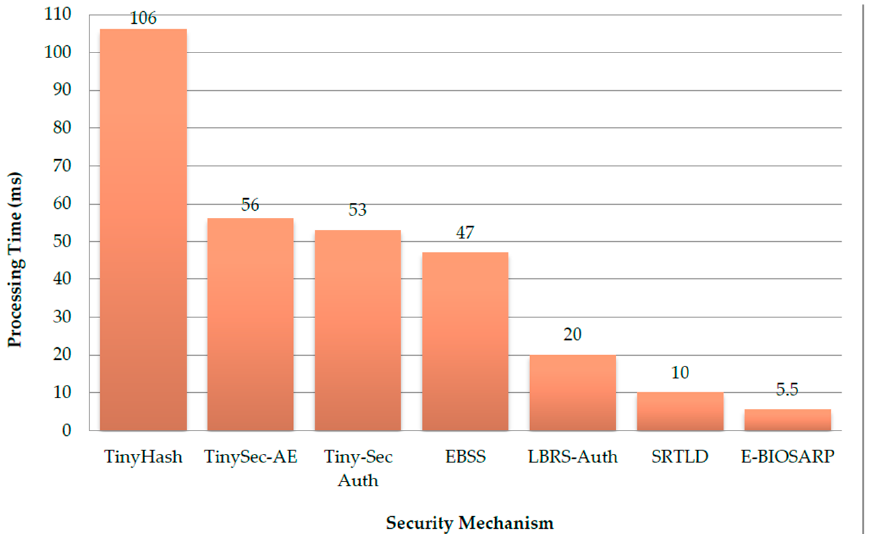
Figure 10. A comparison of the processing time for E-BIOSARP with those for other state-of-the-art security mechanisms: TinyHash, TinySec-AE, Tiny-Sec Auth, EBSS, LBRS-Auth, and SRTLD.